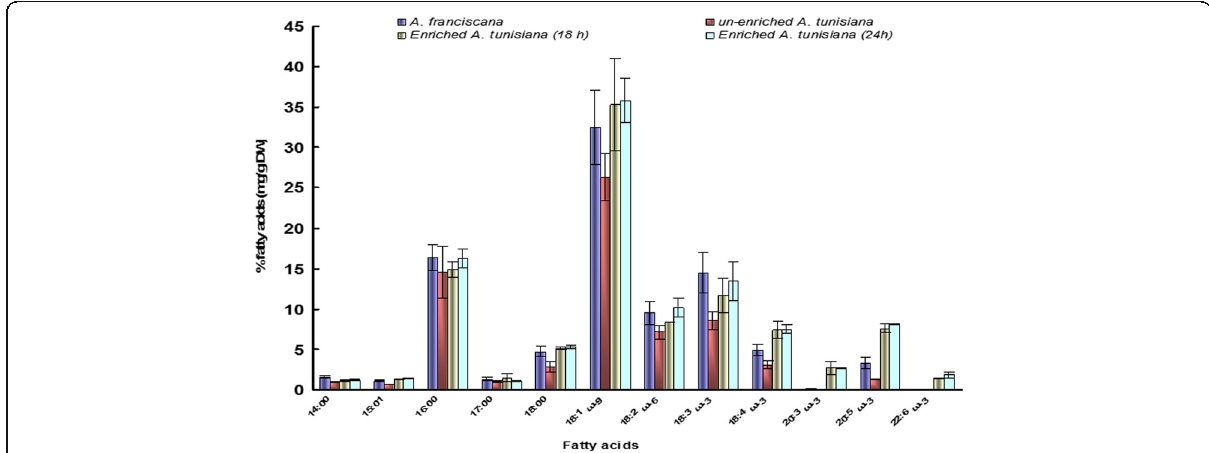
Fig. 2 Fatty acid composition of unenrichment A. franciscana , A. tunisiana , and enrichment A. tunisiana for 18 and 24 h